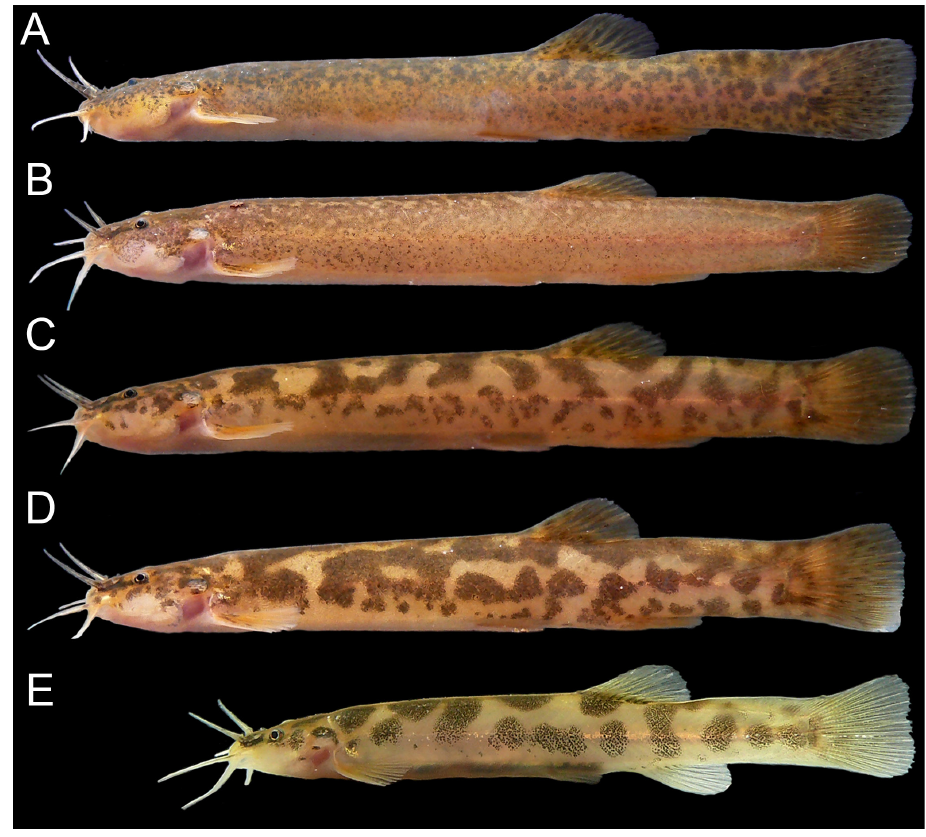
FIGURE 4 | Polymorphic color pattern within of Cambeva barbosae ranging from a mottled color pattern in individuals from ( A ) Santa Catarina Island, UFRGS 23183, 80.1 mm SL, and ( B ) Biguaçu River basin, UFRGS 22907, 61.3 mm SL; to a blotched color pattern with dark marks varying in shape and size from Biguaçu River basin, ( C, D ) UFRGS 22932, 58.7mm SL and 51.0 mm SL, respectively, and ( E ) UFRGS 20937, 30.0 mm